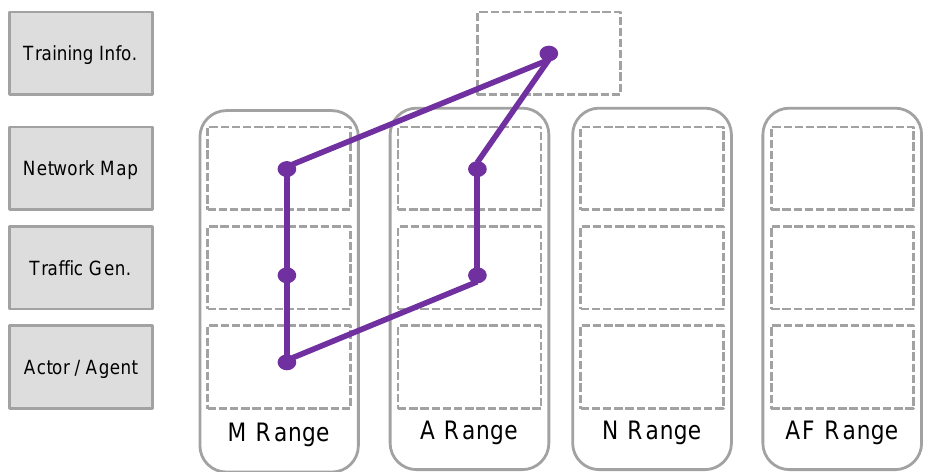
Figure 6. Scenario Authoring through Multi-Range.